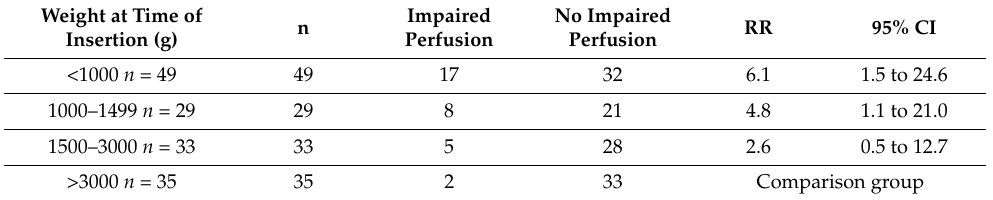
Table 5. Rate of impaired perfusion by weight category at time of insertion. RR = relative risk.